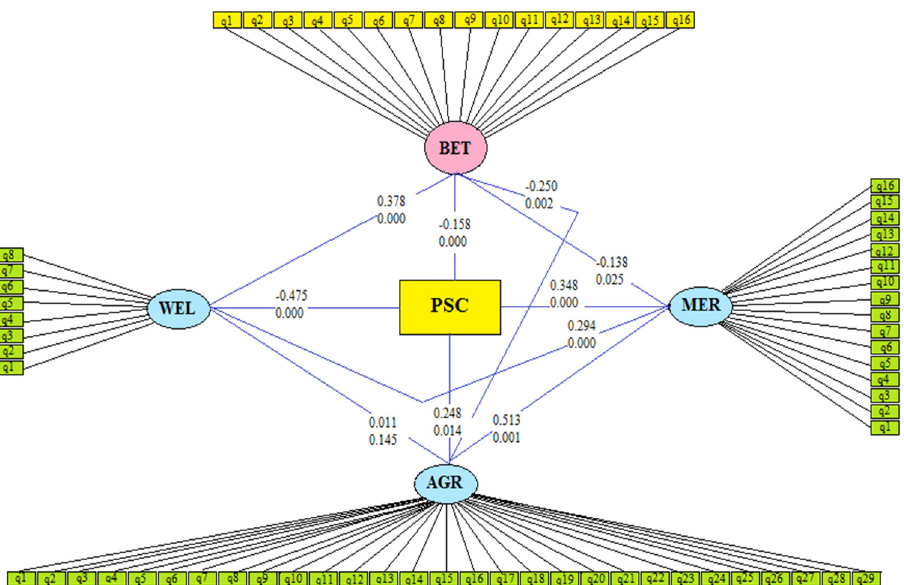
Figure 1. The effect of explicit and implicit variables of Iran’s data.